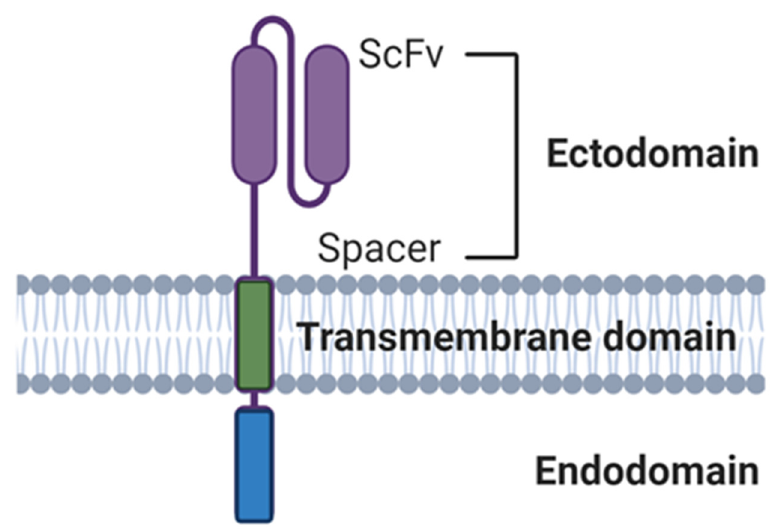
Figure 5. Components of a first-generation CAR. A CAR is made up of the ectodomain (composed of a scFv and hinge), the transmembrane domain and the intracellular signaling endodomain. Abbreviations: scFv; single-chain variable fragment.